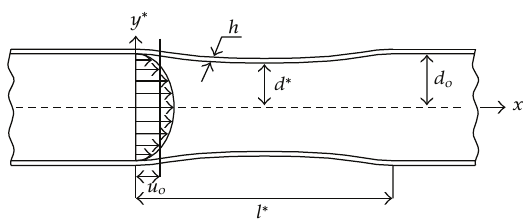
Figure 1: Schematic sketch of 2D collapsible